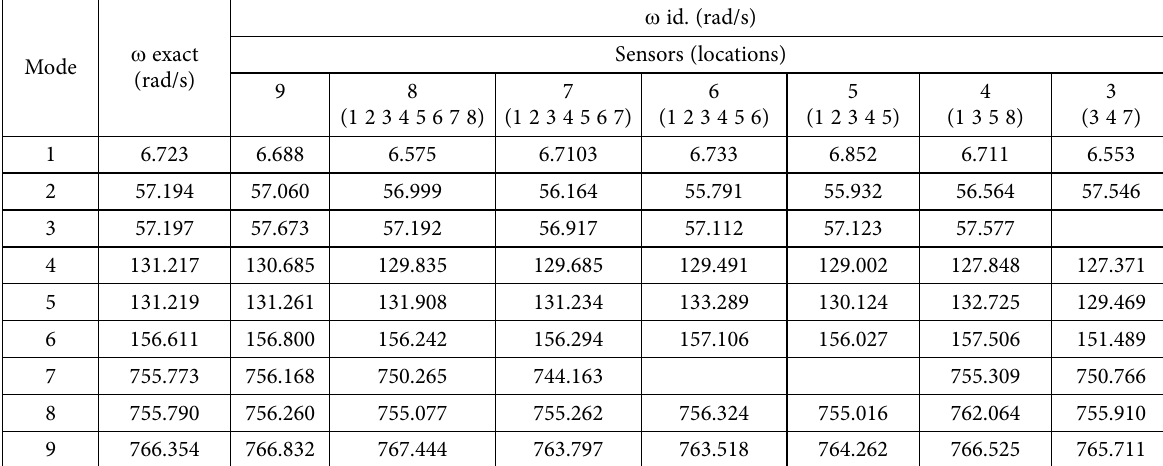
Table 2. The exact and identified natural frequencies of the tripod simplex structure